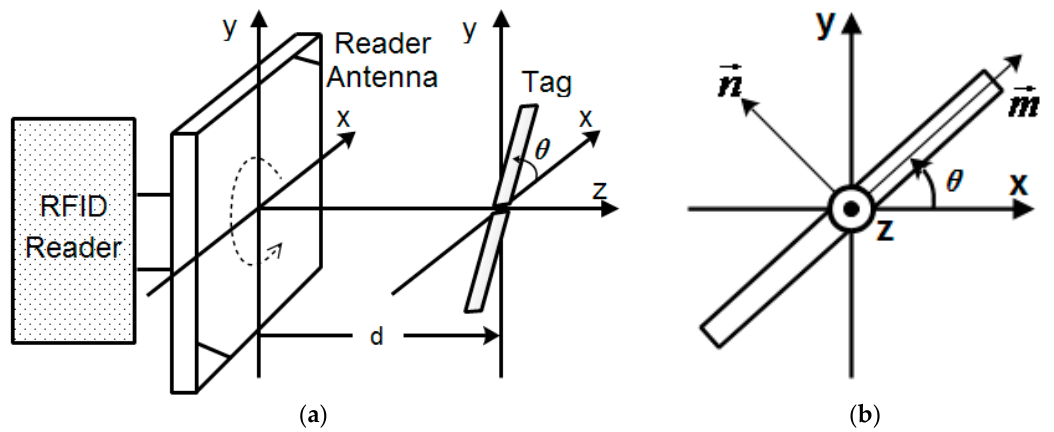
Figure 4. Measurement model: ( a ) Experimental scheme. ( b ) Angular relationship of tag antenna.